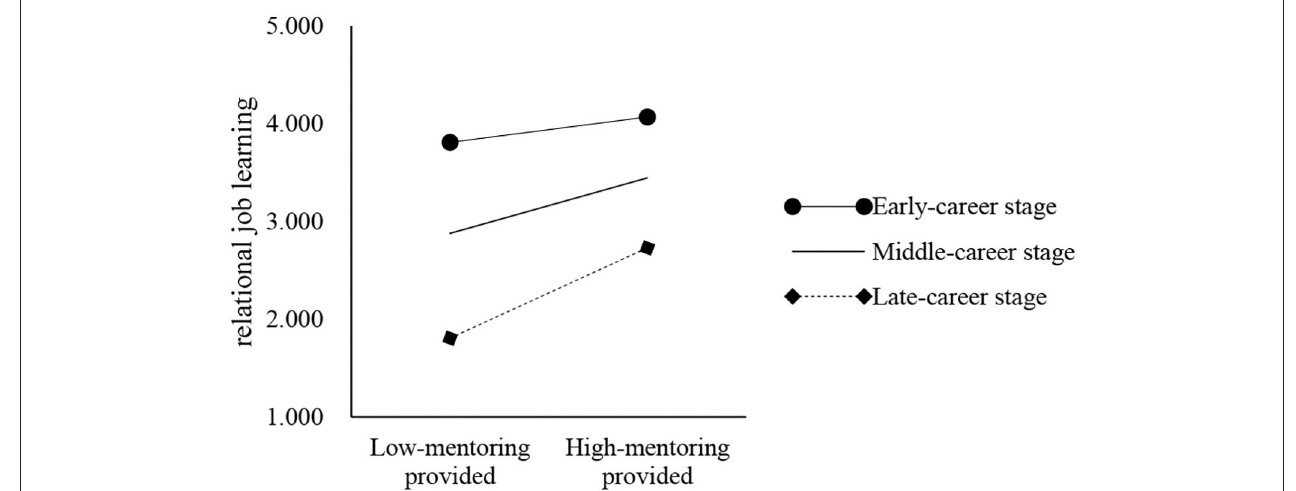
Frontiers in Psychology |